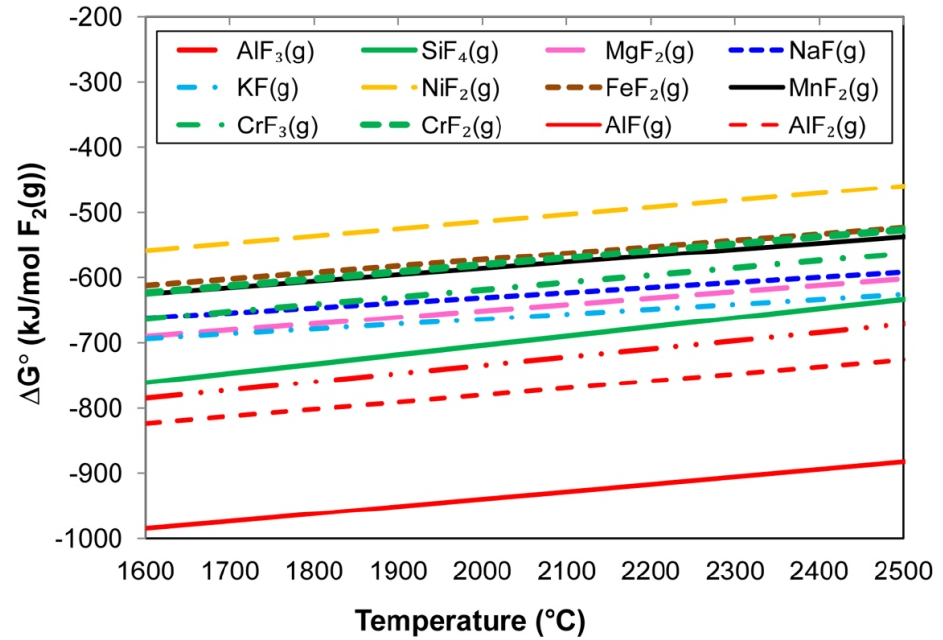
Figure 4. Standard Gibbs free energy values of reactions similar to Equation (10). The following input values were applied in the calculation of the lines of reactions that are similar to Equation (10) in Figure 4: 1 atm for each gas, namely metal vapour, F 2 (g), and the product metal fluoride gas. The calculation inputs for the lines for reactions that are similar to Equation (11), as displayed in Figure 5, were 1 atm CaF 2 (g), unit activity for the molten metal oxides, 0.10 atm for the metal fluoride gas formed, and 0.01 activity for the CaO. The relative positions of the lines in Figure 4 show that formation of NiF 2 (g) is least likely among the metal vapour reactions with F 2 (g) and that aluminium-fluorides AlF 3 (g), AlF 2 (g), and AlF(g) are most probably formed. The formation of CrF 2 (g) is less likely